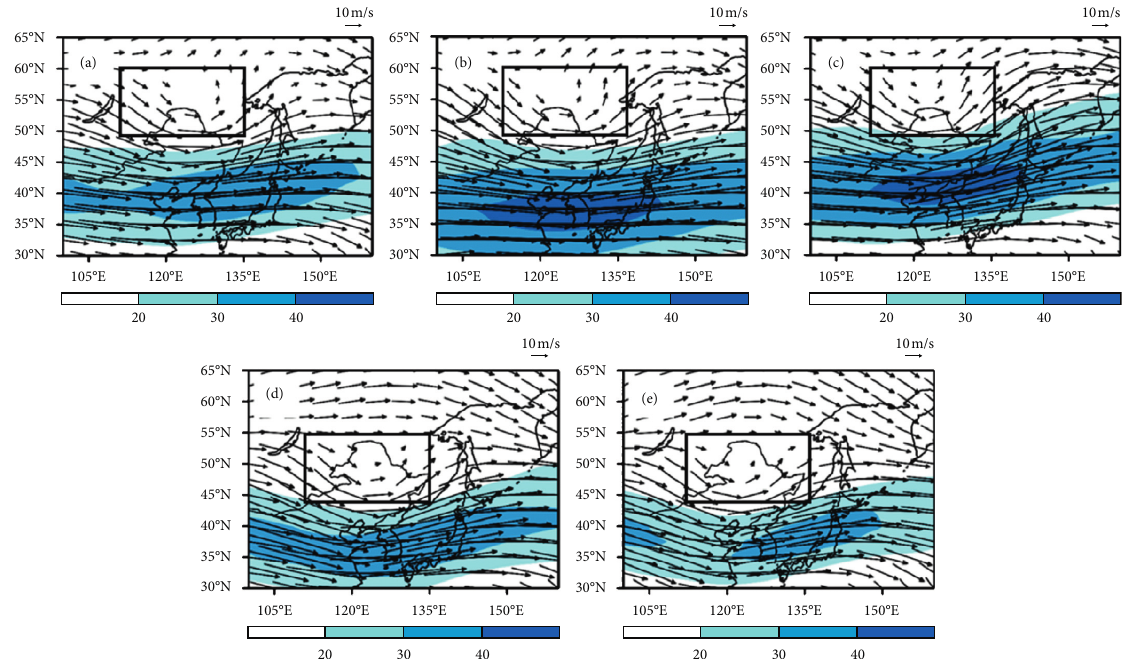
Figure 7: Distribution of wind fields at 200hPa (unit: m · s − 1 ). Areas with wind speed greater than 20m · s − 1 during NCV processes (a) in May to September, (b) late spring (May), and (c) early autumn (September), and MCV processes (d) in May to September and (e) summer. The areas of the black box are the typical locations of NCVs in (a)–(c) and MCVs in (d)-(e).